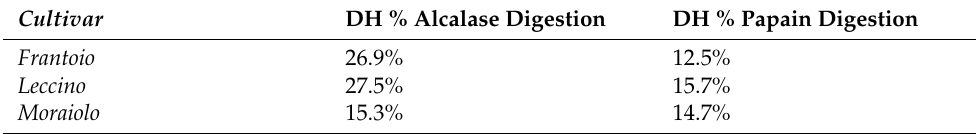
Table 3. Description the degree of hydrolysis (DH, %) using alcalase and papain enzymes.